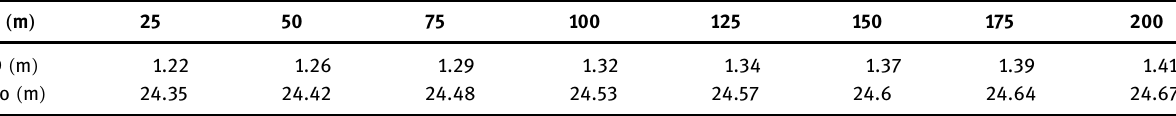
Table 4: Value of optimum diameter and optimum span length vs pipe length